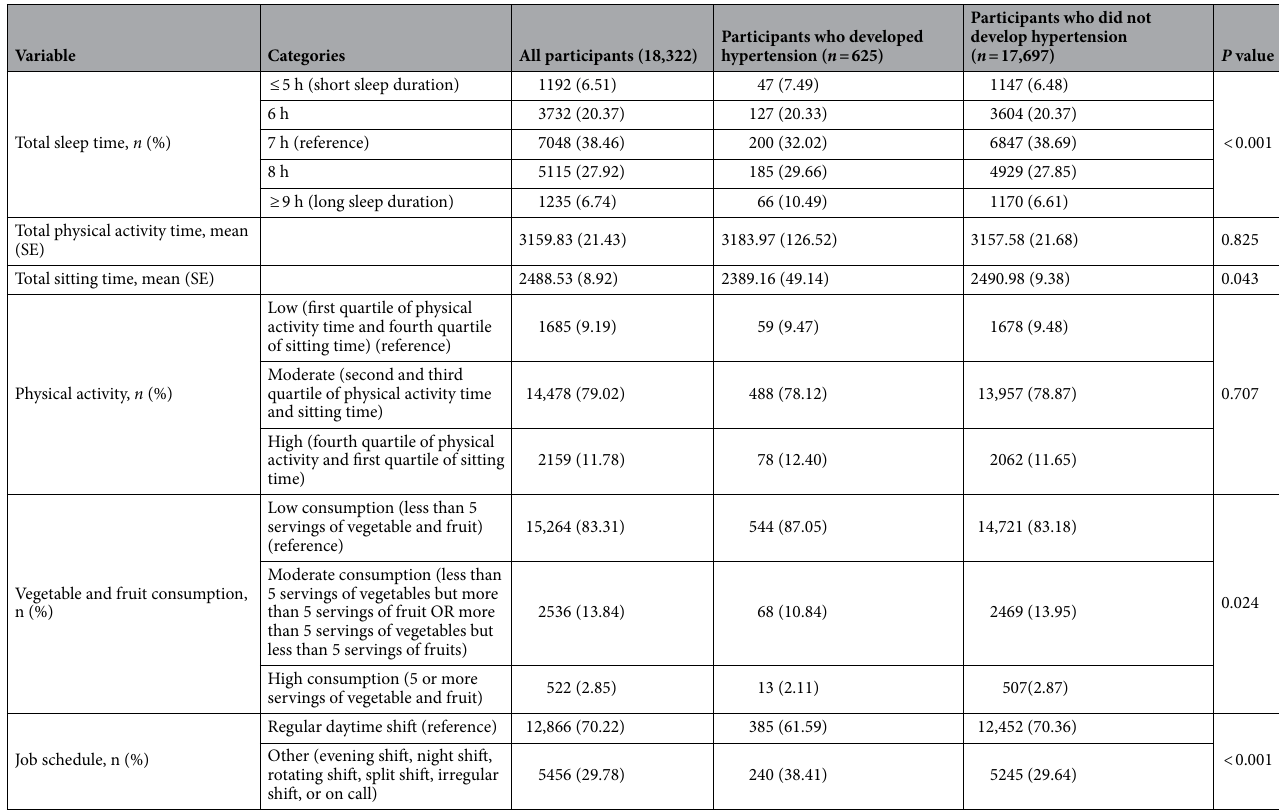
Table 1. Baseline characteristics of study participants according to the status of developing hypertension or